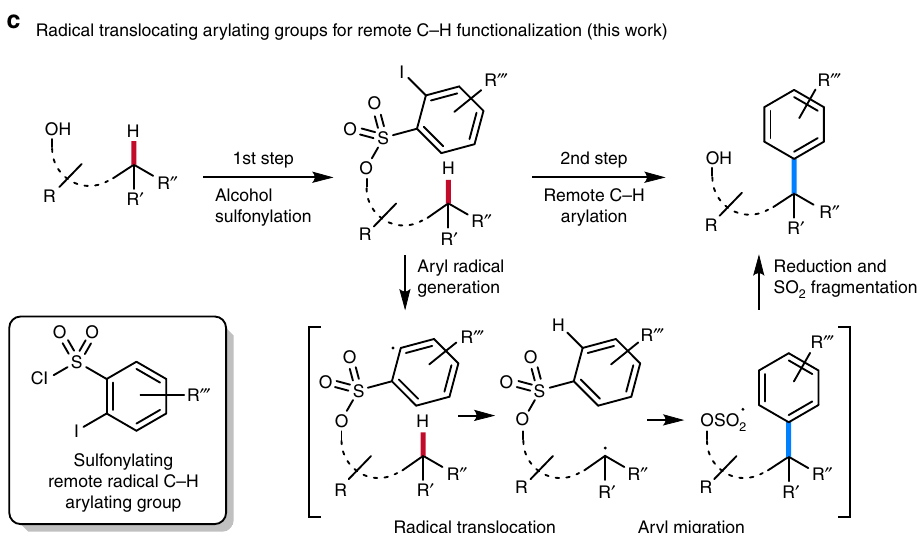
Fig. 1 Remote C − H functionalization. a Different substrates for transition-metal catalyzed direct C(sp 2 ) − H and C(sp 3 )-arylation containing a functional group to direct the C − H activation step. The directing group controls regiochemistry of the C − H activation step. b Remote C − H functionalization via radical H-atom transfer from C − H to activated N- and O-centered radicals. c Two step remote radical C − H arylation comprising radical translocation and subsequent radical aryl